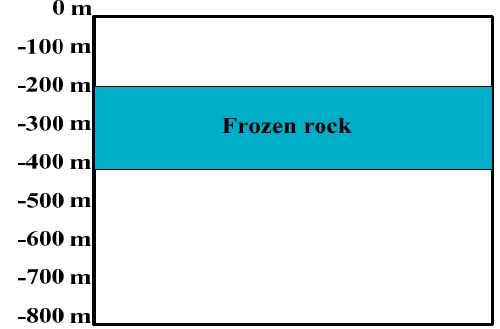
Figure 15. Layered polarization model of frozen rock.